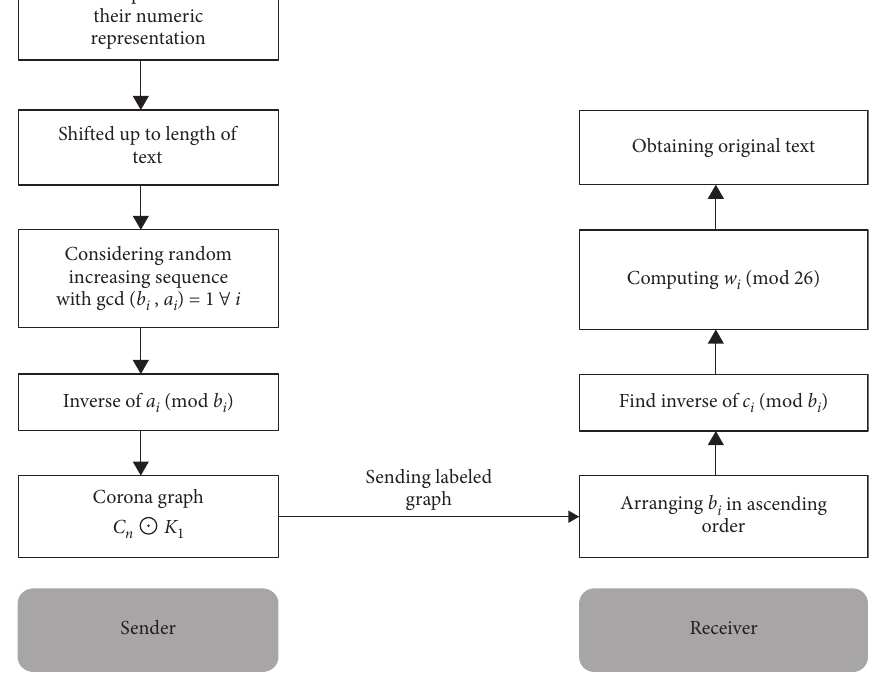
Figure 1: Schematic